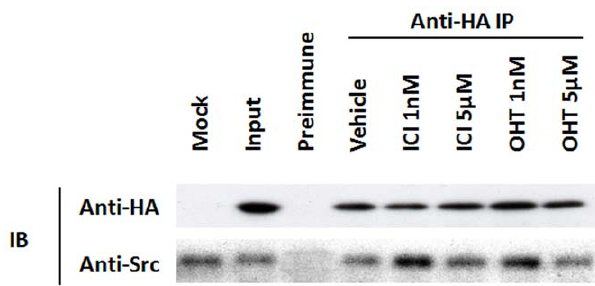
Figure 7. Different concentrations of antiestrogens affect the association of ER- a 36 and Src differently. Co-immunoprecipita- tion and Western blot analysis of HA-ER- a 36 and Src in MDA-MB-231 cells. Cells transiently transfected with an expression of HA-tagged ER- a 36 and treated with different concentrations of antiestrogens for 10 min were lysised and the cell lysates were immunoprecipitated with pre-immune and anti-HA antibodies. The immunoprecipitates were blotted by anti-HA and anti-Src antibodies.